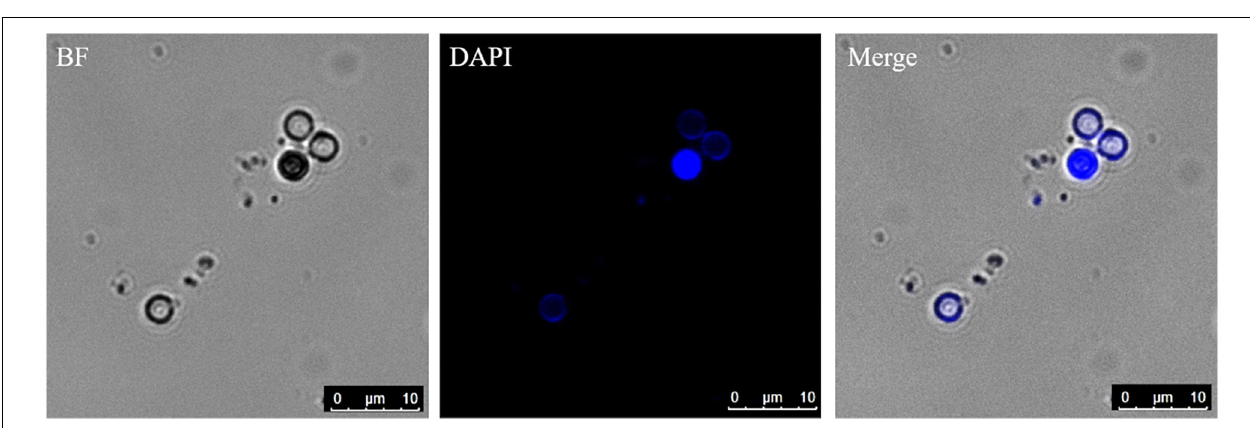
FIGURE 10 | Resting spores stained with DAPI to distinguish the germinated from non-germinated spores with CLSM. The blue spores are non-germinated spores and the colorless spores are germinated spores. BF, bright field.